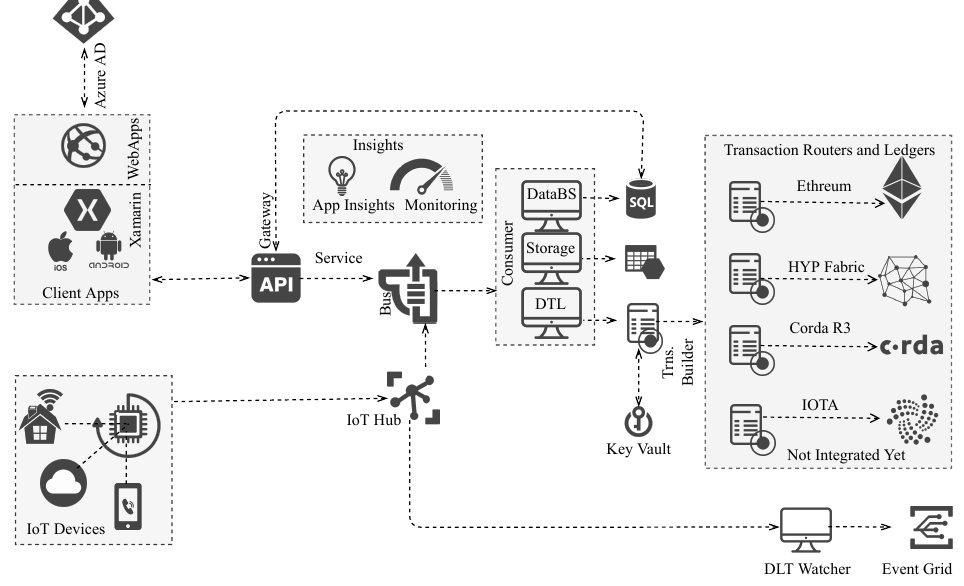
Figure 4. Azure IoT reference architecture that has been integrated with BC for securing IoT